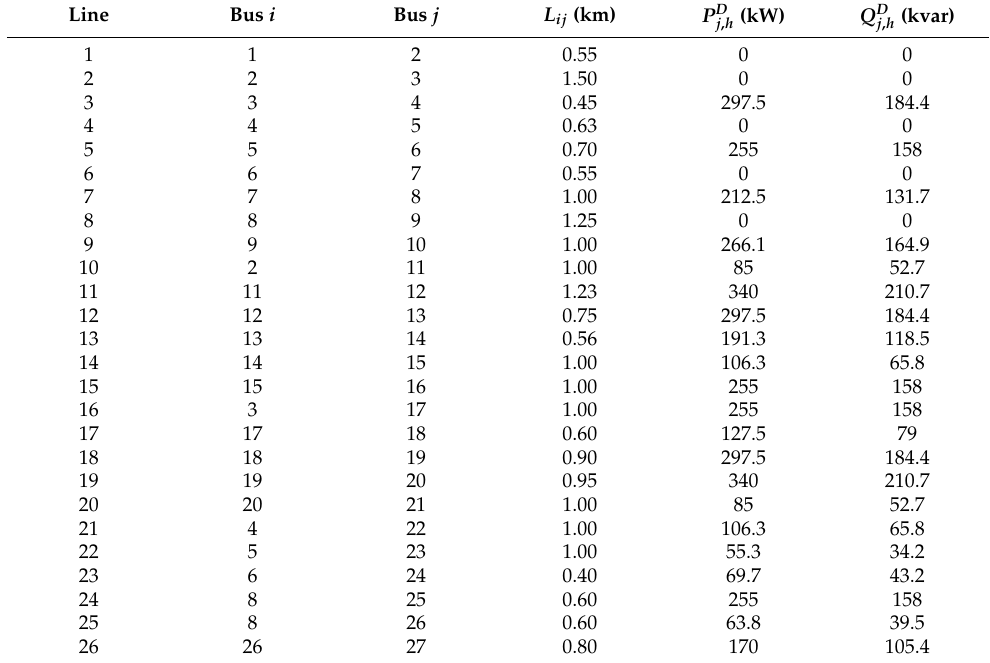
Table 7. Connection of lines and load levels of the system for the balanced case in the 27-bus test system.